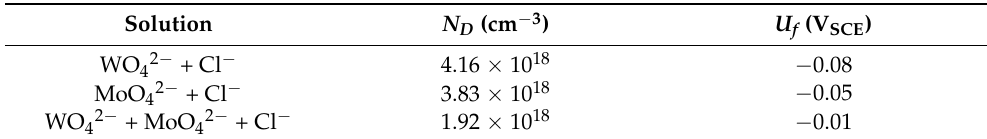
Table 5. Fitted values of N D and U f for Q235 carbon steel in WO 42 − + Cl − , MoO 42 − + Cl − and WO 42 − + MoO 42 − + Cl −